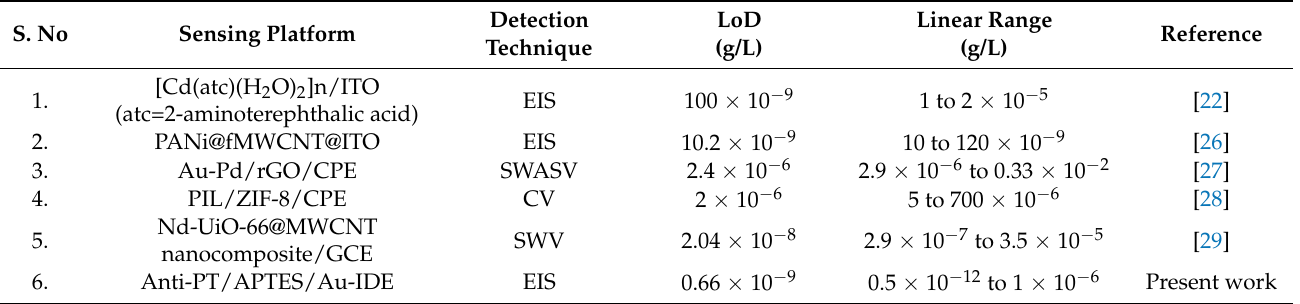
Table 3. Comparison of other reported sensors for the electrochemical detection of parathion